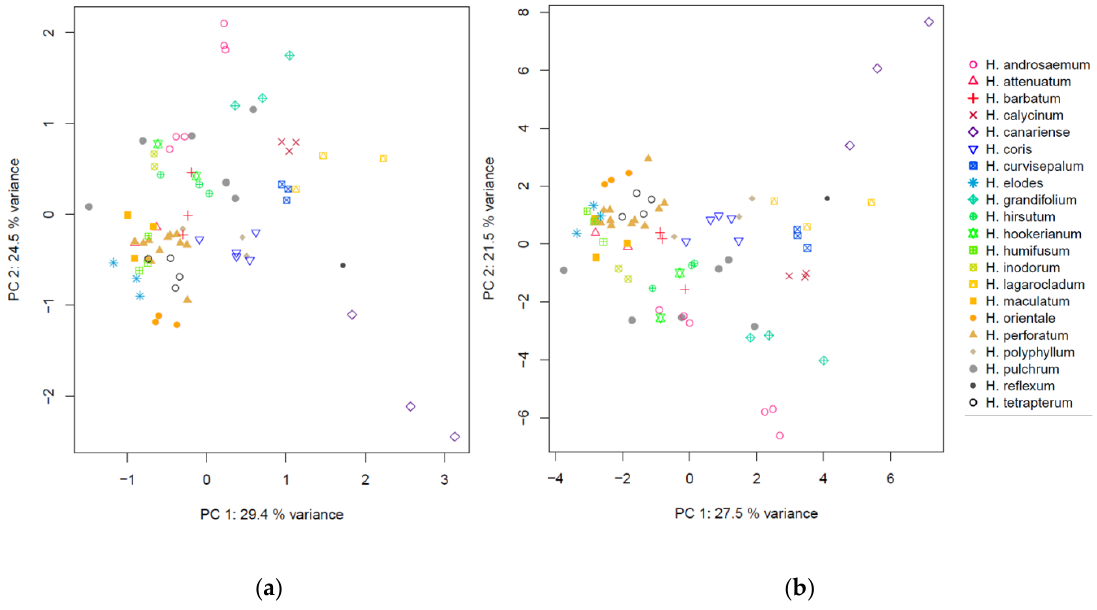
Figure 7. Scores plot of principal component analysis (PCA) of Hypericum species based on ( a ) conventional 1 H-NMR and ( b ) PSYCHE spectra.